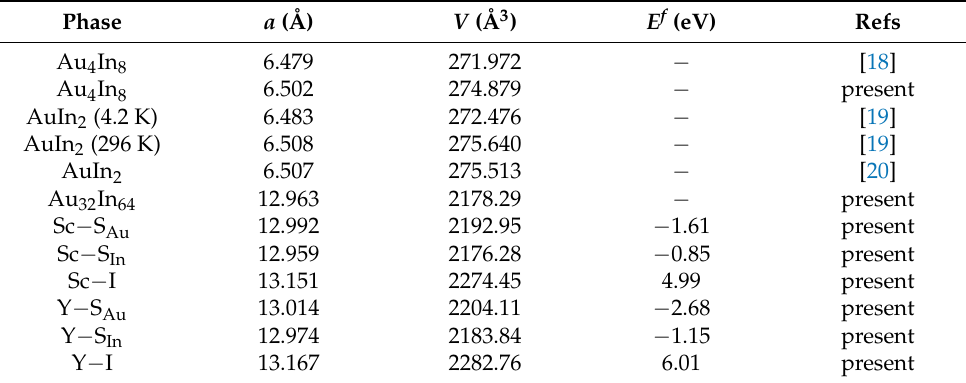
Table 1. Structural parameters and formation energy of AuIn 2 and doped system.